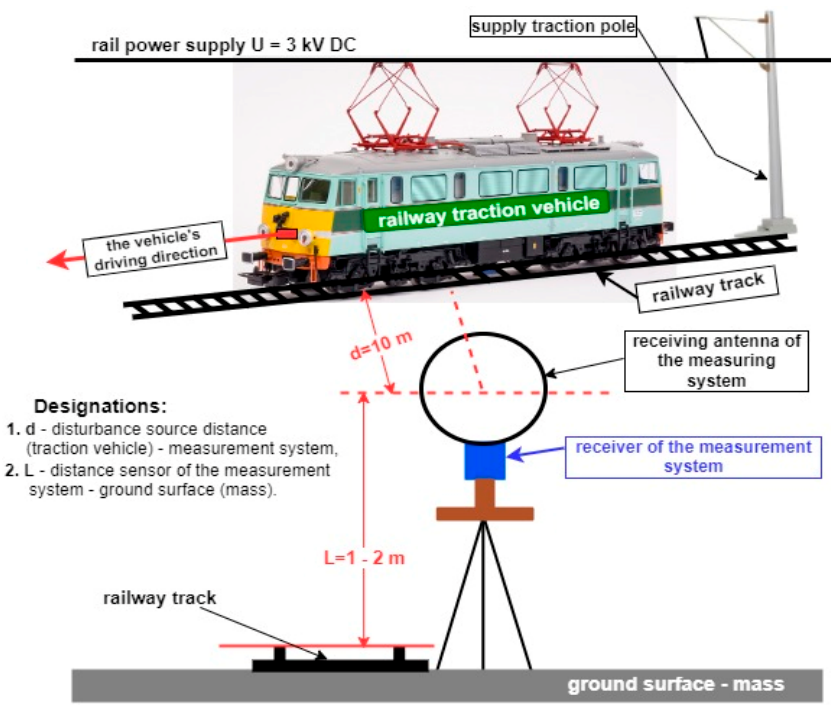
Figure 5. Measurement of radiated interference emission in the 150 kHz ÷ 30 MHz frequency band using a loop